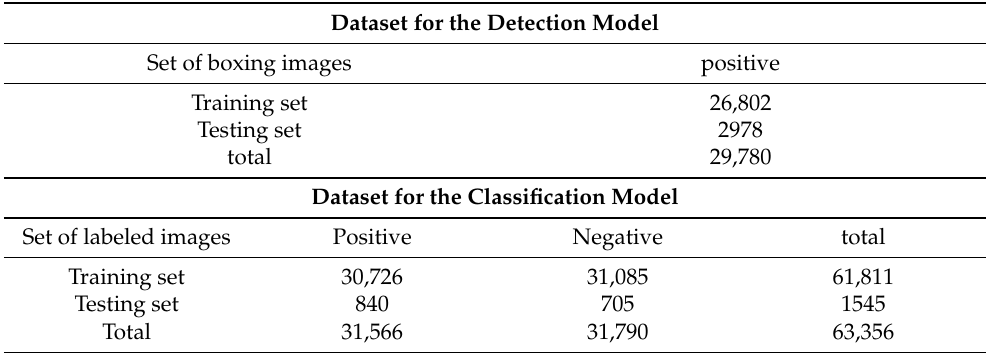
Table 3. Number of images in the developed datasets.